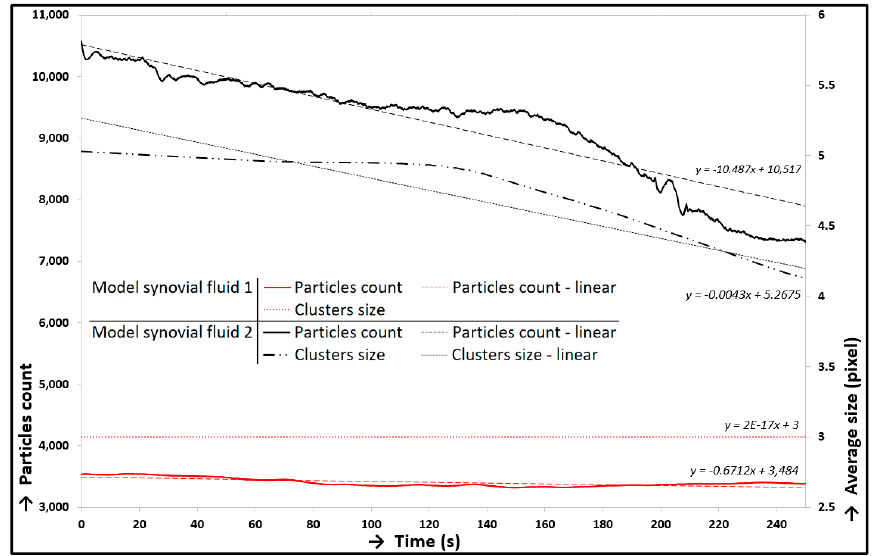
Figure 15. Particle count / average size / time-dependence: Model Synovial Fluids 1 and 2. Table 4. Evaluation outputs from experiments: percentage deviations of measured